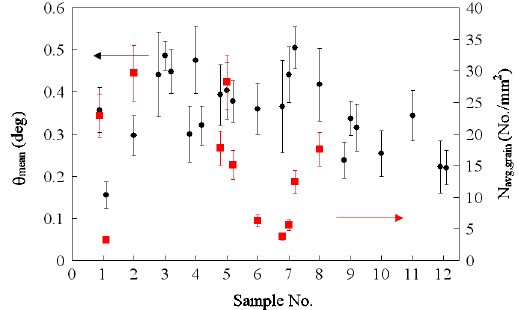
FIG. 13. Mean values of the local average misorientation dis- tributions, obtained from the EBSD data on each grain for all the samples (black circles) and average density of pits measured on each grain for six samples (red squares). Samples with more than one grain have multiple points in the plot, corresponding to the different misorientation angle distributions for each grain. The N values are plotted in the position correlated with the avg ; grain value of (cid:2) for that grain. mean